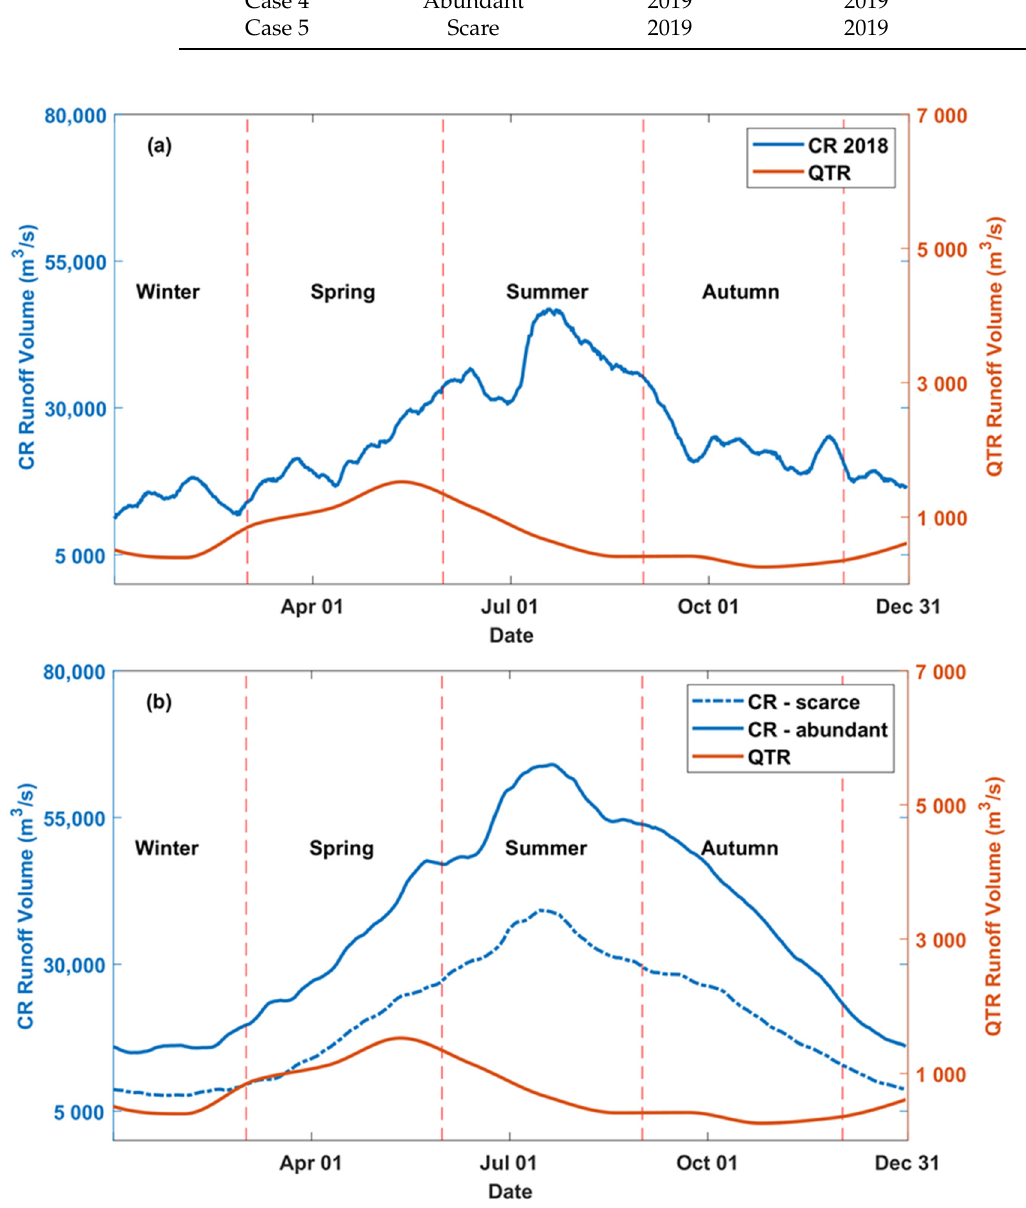
Figure 4. The runoff volume set in ( a ) case 1—2019, ( b ) case 4—abundant and case